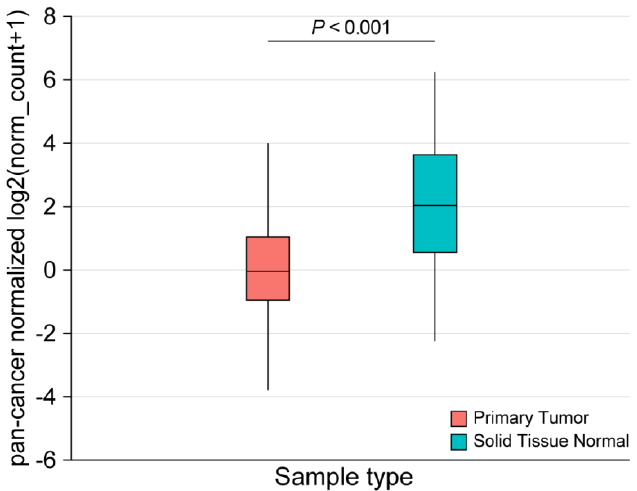
Figure 2. CD200R1 mRNA expression in tumors (blue box) and normal tissues (purple box) in TCGA HNSCC ( n = 602) using the Xena platform (Welch’s t -test, p < 0.001). To further elucidate the biological function of CD200R1, we performed differential expression (DE) analysis between tumors with high and low CD200R1 expression from the GEO and TCGA datasets, respectively. A total of 130 genes were identified in the GEO data with a fold change > 1.5 and adjusted p -values of <0.05 using the Benjamini‒Hochberg method (Figure 3a).